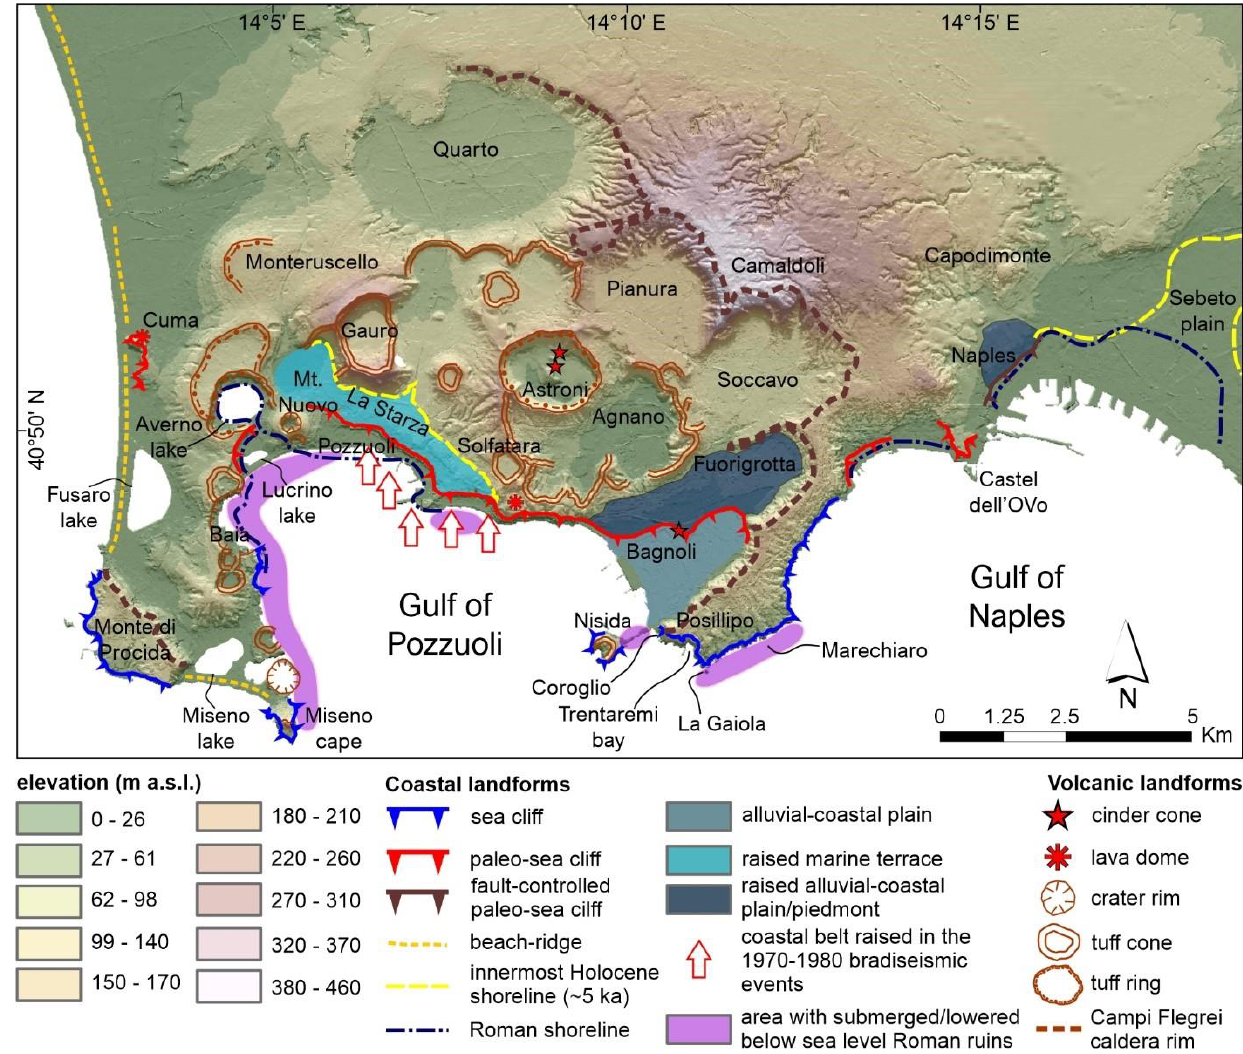
rings, tuff cones, cinder cones and lava domes (Figure 2) [41–45]. The last volcanic event in the Campi Flegrei occurred in 1538 AD with the formation of Monte Nuovo volcano [46,47] (Figures 1 and 2).